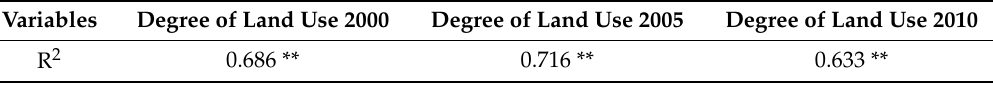
Table 8. Correlations between the land use degree and the distribution of grassland